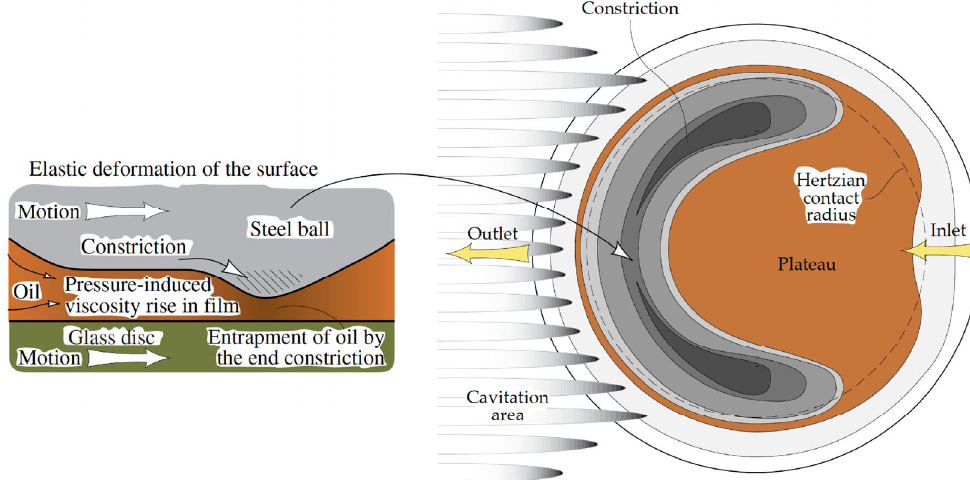
Fig. 2 Elastic oil entrapment effect in elastohydrodynamic lubrication (adapted from Refs. [9,